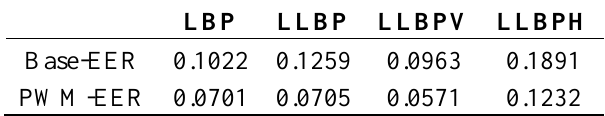
Table 10. Verification performance by different methods.